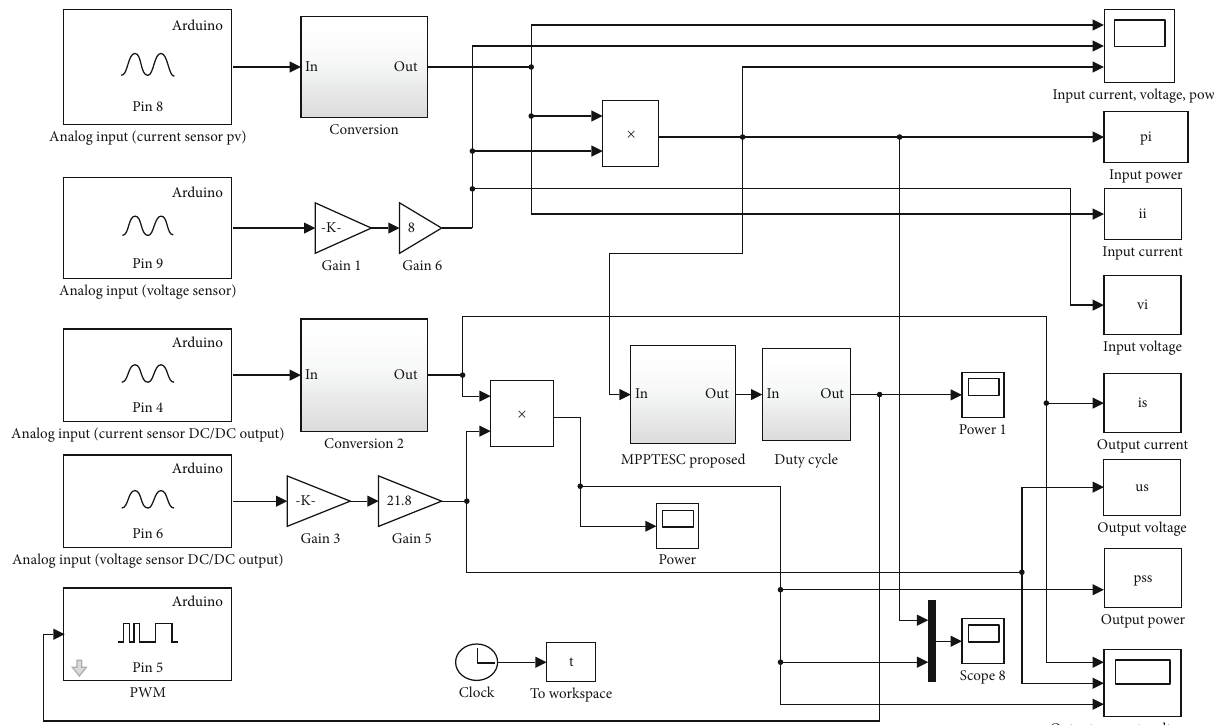
Figure 18: Experimental design of the proposed algorithm using Arduino under Matlab